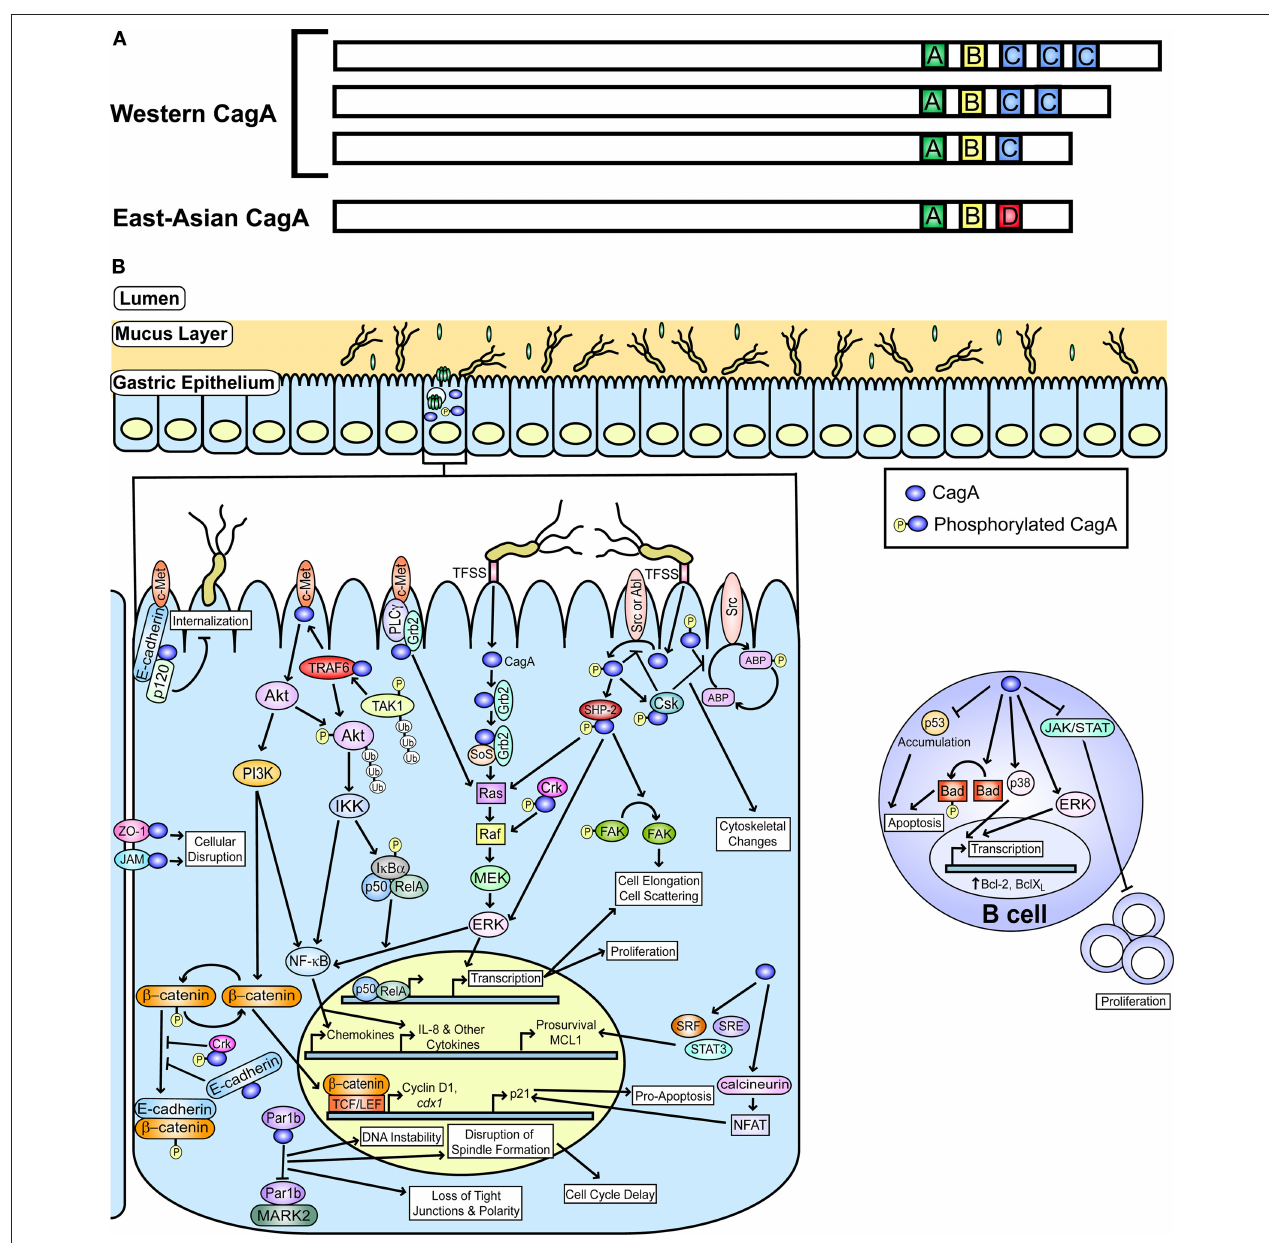
impacted by phosphorylated and non-phosphorylated CagA is shown. Pathways targeted in epithelial cells and B cells are indicated. The actin binding proteins (ABP) affected by CagA include vinculin, cortactin, and ezrin. This figure was adapted from an earlier version by Rieder et al.